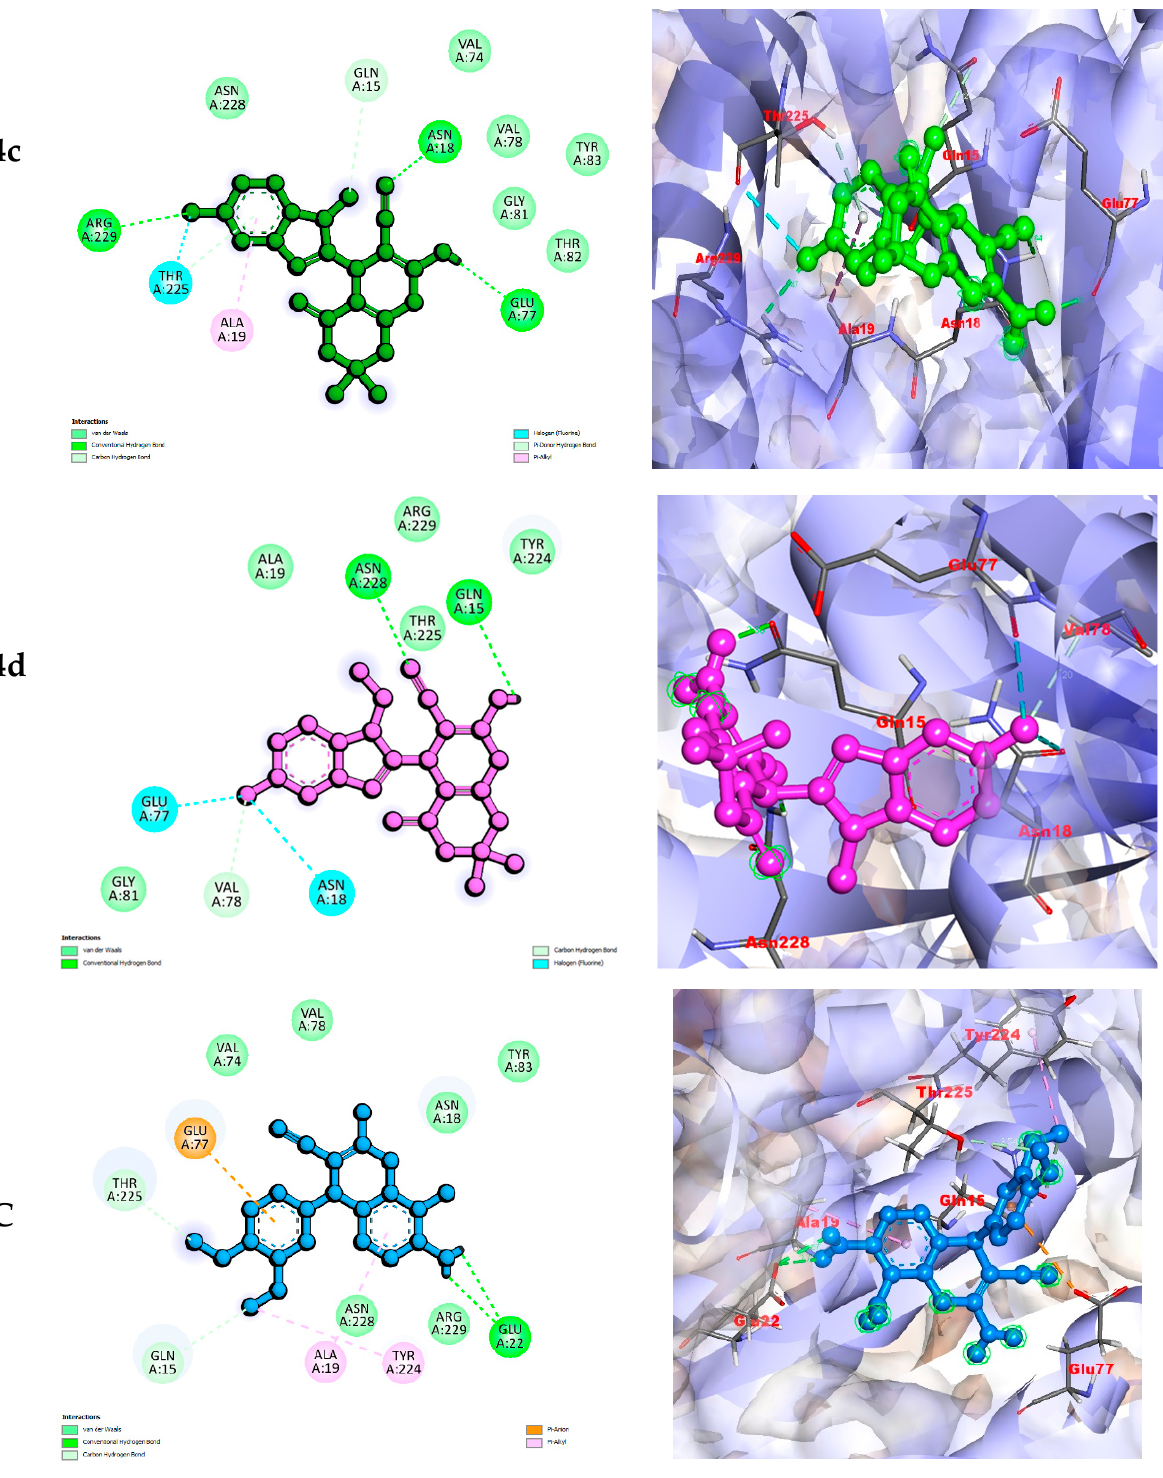
Figure 2. In silico binding interactions of the active derivatives 4c (green) and 4d (pink) with tubulin protein (6JCJ). Crolibulin ( C , blue) was used as a positive control in the docking experiment. Table 4. Docking analysis of the covalent and non-covalent interactions of the derivatives ( 4c and 4d ) with the target protein, tubulin (6JCJ).